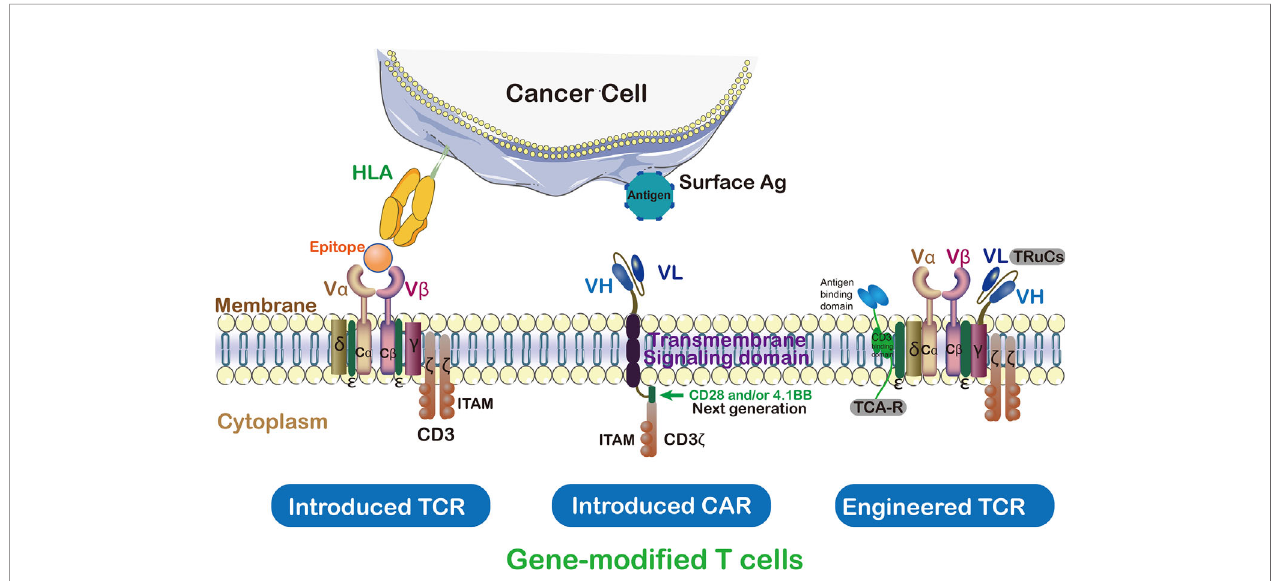
FIGURE 3 | TCRs vs CAR and genetically modi fi ed T cells in immunotherapy. Cancer targeting receptors, TCR and CAR, are introduced to the activated T cells to empower them against special type of cancer. z subunit of CD3 on the surface of T cell is essential for triggering signaling cascade of T cells. In contrast to TCR which needs to be activated by endogenous CD3, CARs are hybrid receptors manufactured from a single-chain variable fragment (scFv) attached to z subunit of CD3. Both introduced and endogenous TCRs recognize HLA peptides on cancer cells. The CARs, instead, do not recognize HLA directly which trigger T cell signaling cascade in a TCR-independent manner.